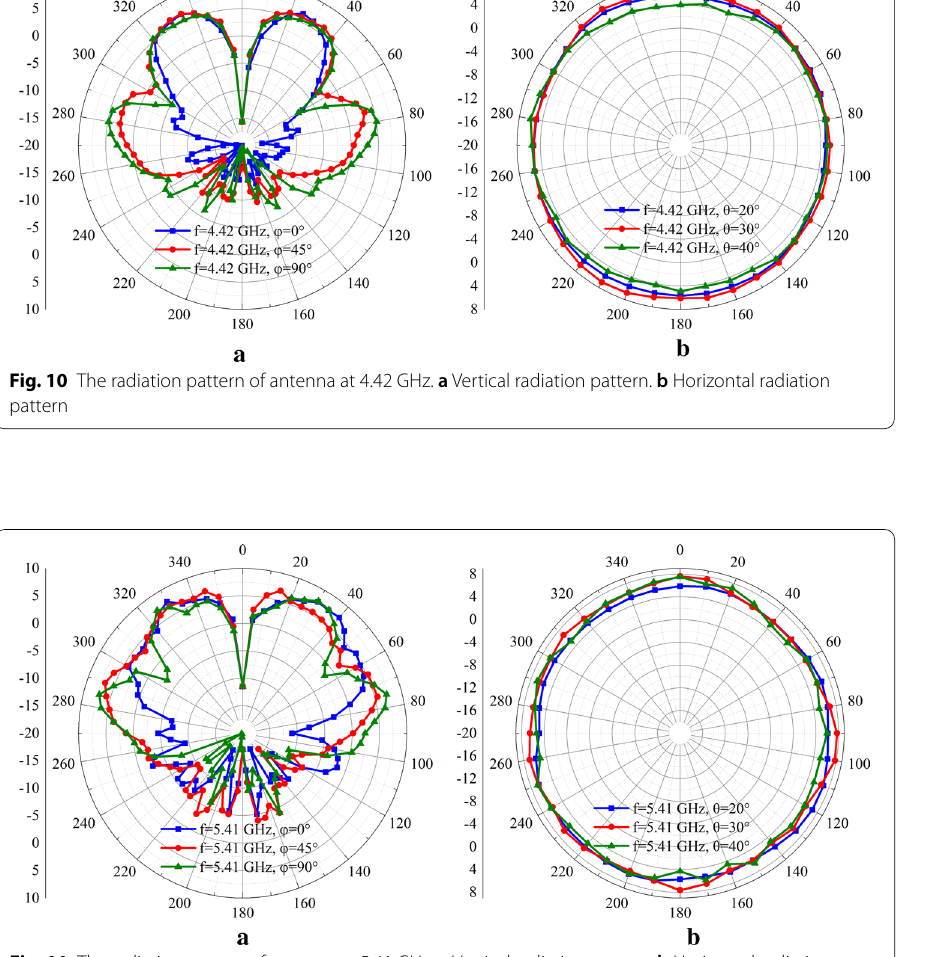
Fig. 11 The radiation pattern of antenna at 5.41 GHz. a Vertical radiation pattern. b Horizontal radiation